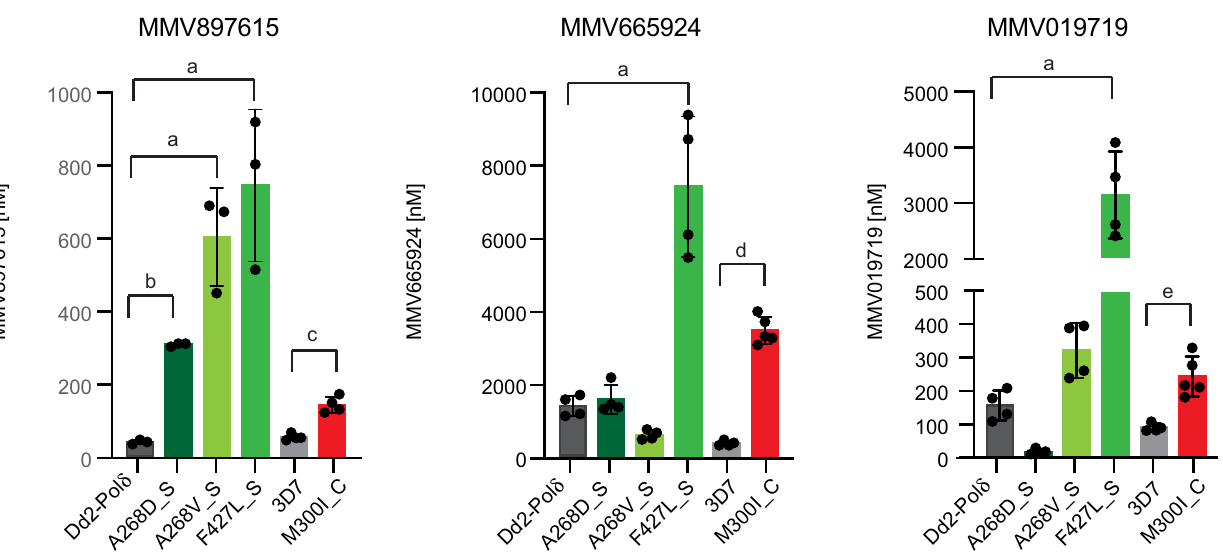
Fig. 2 | Mutations in Pf ACS10 can cause collateral sensitivity to distinct che- motypes. Mean EC 50 ±SD values for strains containing mutations in Pf ACS10 selected in the Dd2-Pol δ line (A268D, A268V, and F427L) and in 3D7 (M300I), are shown for MMV897615, MMV665924, and MMV019719. Assays were run in triplicate and at least repeated twice. ANOVA with Dunnett post-tests